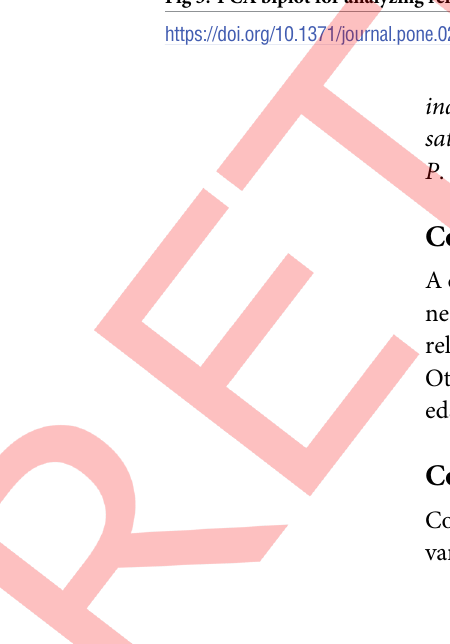
Fig 3. PCA biplot for analyzing relationship between weed communities’ density in different wheat